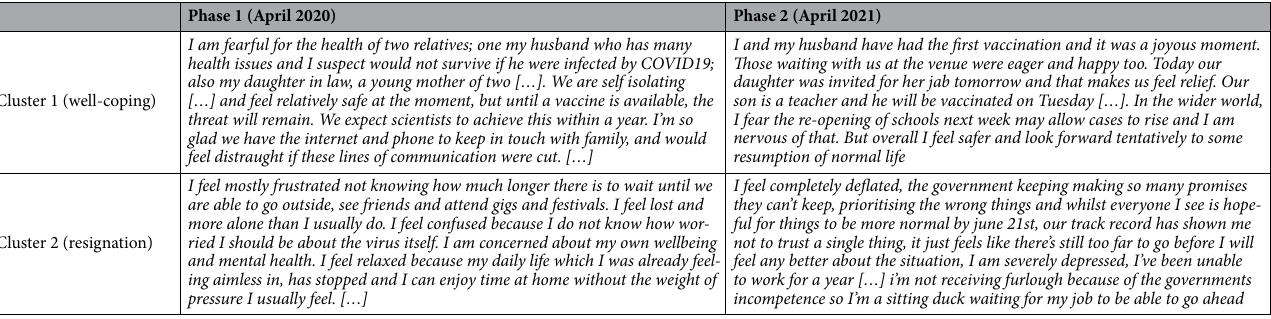
Table 4. Examples of texts written by participants in each cluster (long texts only).